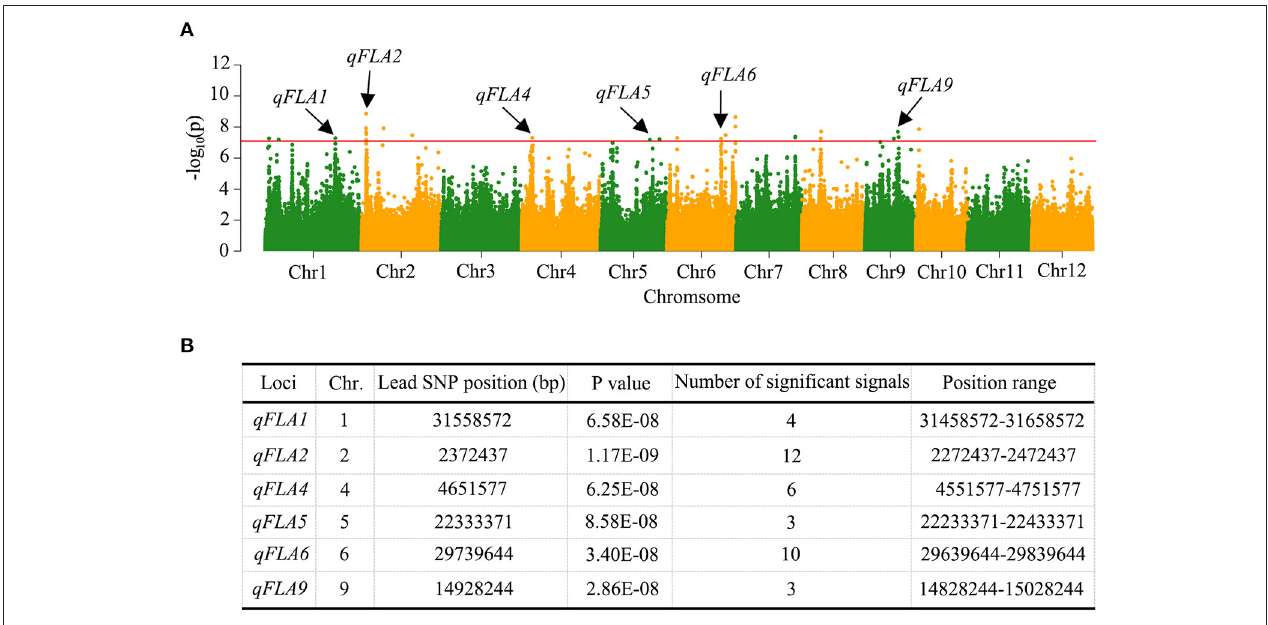
FIGURE 2 | Quantitative trait locus (QTL) identification for FLA by genome-wide association study (GWAS) in rice. (A) Manhattan plots for the whole population of rice accessions. The vertical axis indicates the negative log 10 -transformed P -values. The dots above the red line mean the significant single nucleotide polymorphisms (SNPs) in the QTL region. The black arrows indicate the QTL identified. (B) Information of the identified